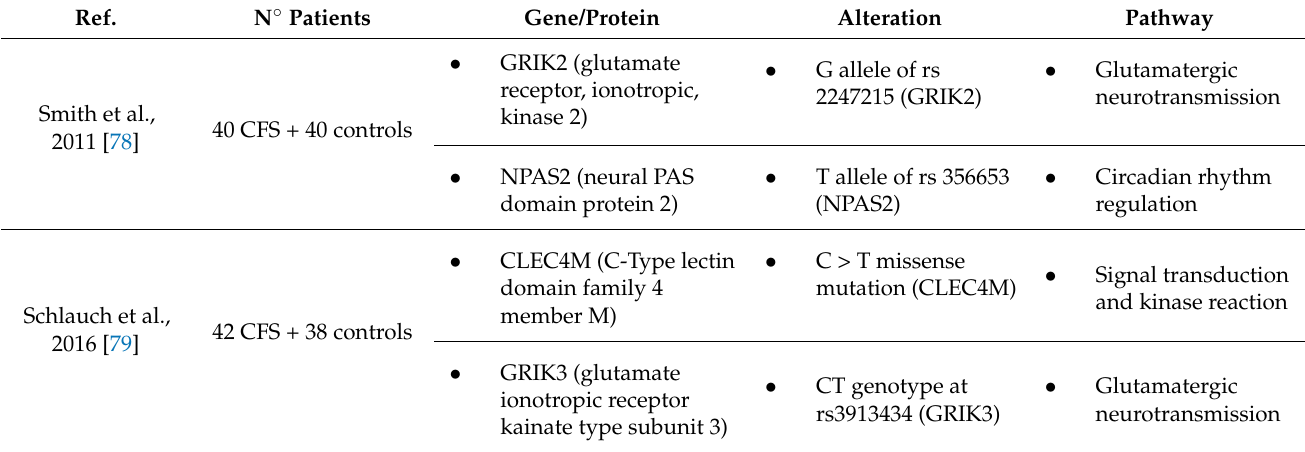
Table 1. Summary of the most significant genetic alterations found in CFS patients.